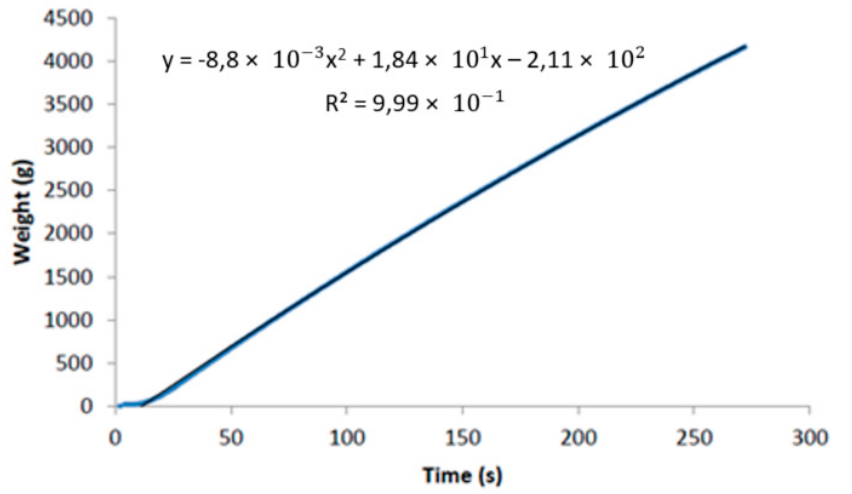
Figure 7. Water flow through permeable water-resistant heat insulation panel with missing membrane layer.